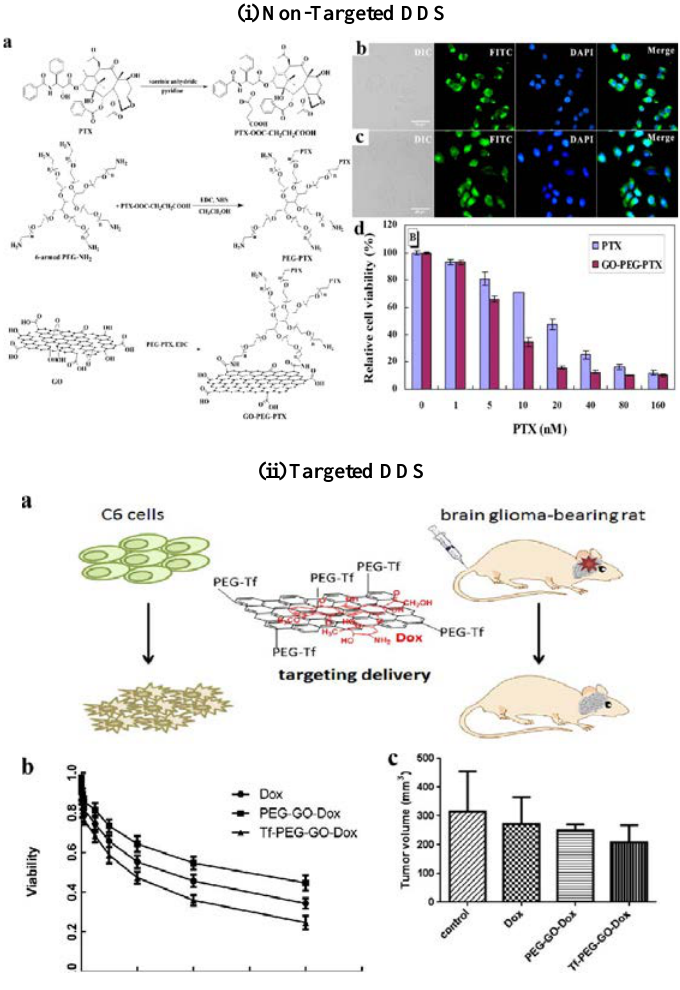
Fig. 2. Graphene-based nanomaterials for drug delivery. (i) Non-targeted drug delivery system (a) Preparation of GO-PEG-PTX Nanoscale Drug Delivery System. Di®erential interference contrast (DIC), FITC, DAPI, and merge ( FITC þ DAPI ) images of A549, (b) and MCF-7, (c) cells incubated with GO-PEG-FITC for 3h; scale bar 25 (cid:2) m, (d) Relative cell viability of MCF-7 cells after treatment with di®erent concentrations of PTX and GO-PEG-PTX for 72h. Reproduced with permission from Ref. 20. Copyright 2014 American Chemical Society. (ii) Targeted drug delivery system (a) Schematic represen- tation of targeted delivery of Tf-PEG-GO-Dox to cells in vitro and in vivo . (b) C6 viability – concentration curves for Dox, PEG-GO-Dox, and Tf-PEG-GO-Dox. (c) Glioma volume in di®erent therapeutic groups on the 14th day. Reproduced with permission from Ref. 25. Copyright 2013 American Chemical Society. (iii) Internal-stimulus responsive drug delivery system. Schematic diagram showing antitumor activity of redox-sensitive DXR-loaded NGO-SS-mPEG Reproduced with permission from Ref. 40. Copyright 2012 Wiley-VCH Verlag GmbH & Co. KGaA, Weinheim. (iv) External-stimulus responsive drug delivery system. Schematic representation of photothermally triggered cytosolic drug delivery via endosomal